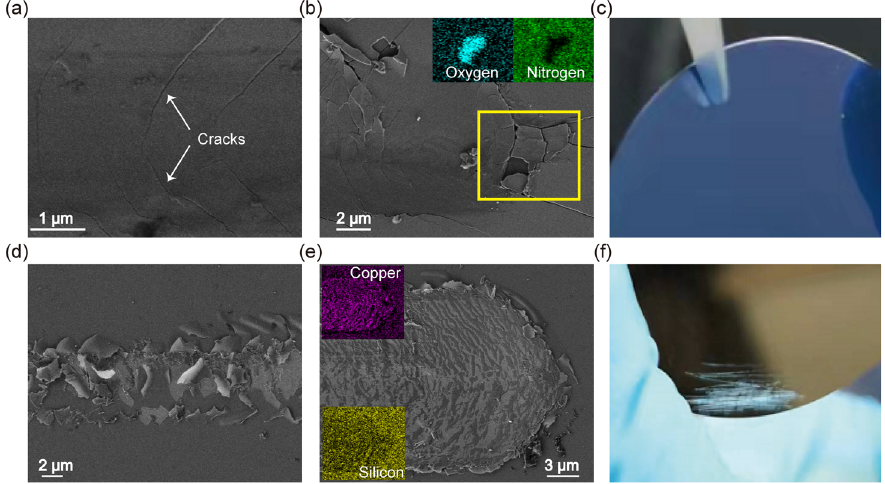
Fig. 4 Scanning electron images and energy dispersive x-ray maps (Insets) of the scratched areas on TiAlN(30nm)-TiN(50nm) coating ( a , b ), and on Si(50nm)-Cu(50nm) coating ( d , e ). The scratch tests were performed by a diamond indenter. Scratch tests on TiAlN-TiN coating ( c ) and Si-Cu coating ( f ) by a stainless-steel